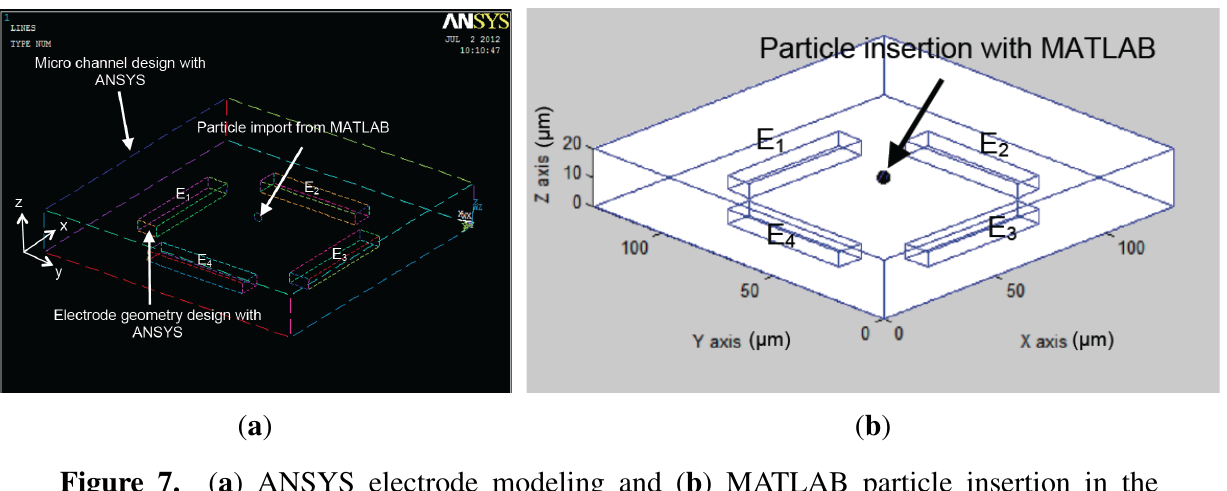
Figure 6. ( a ) Electrode modeling using ANSYS and ( b ) particle insertion with MATLAB in the micro-channel within a 4-electrode architecture.